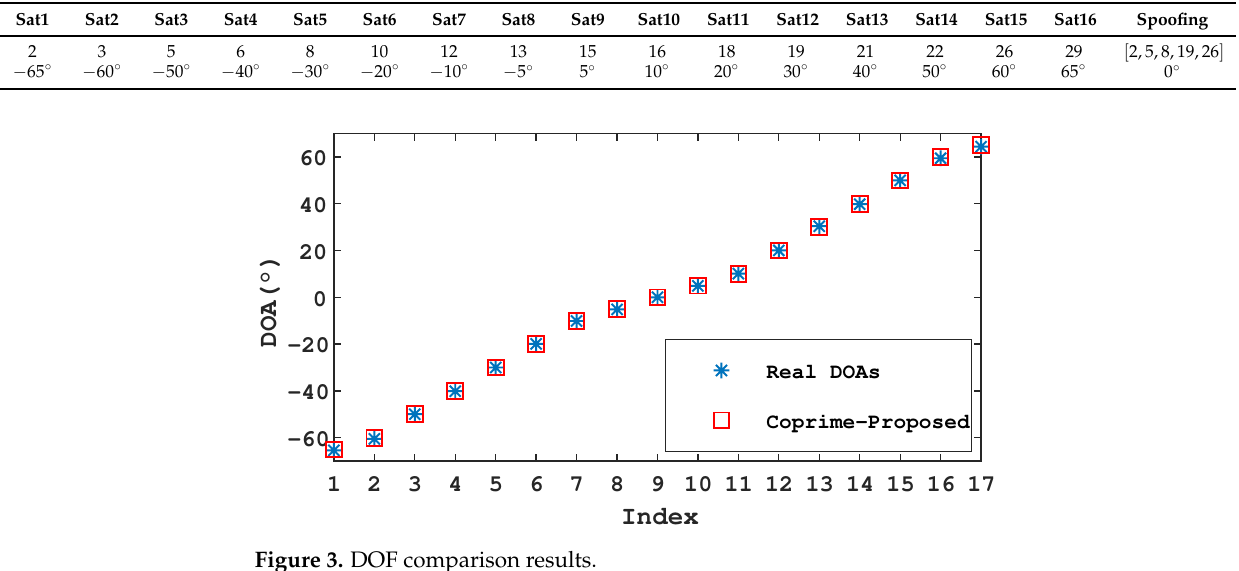
Table 2. Simulation parameters of incident sources in Section 4.1.